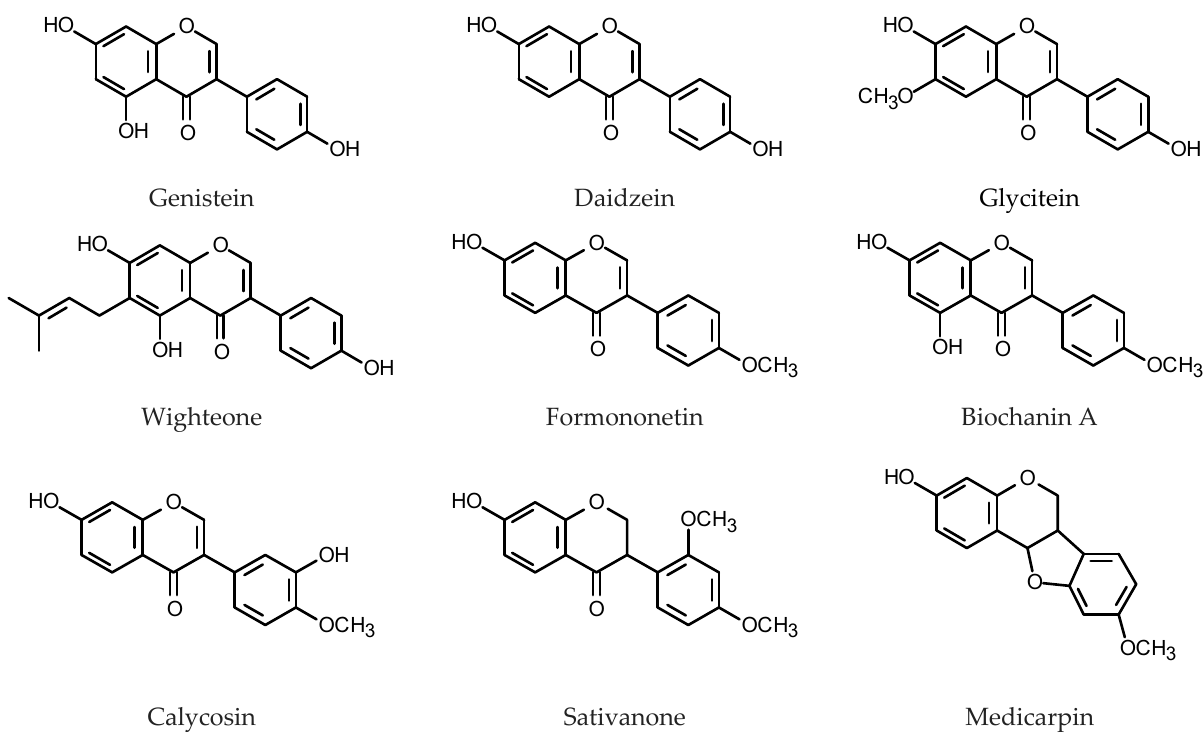
Figure 5. Chemical structures of selected isoflavonoids. Simultaneous silencing of flavone synthase II genes ( GmFNSII-1 and GmFSNII-2 ) in